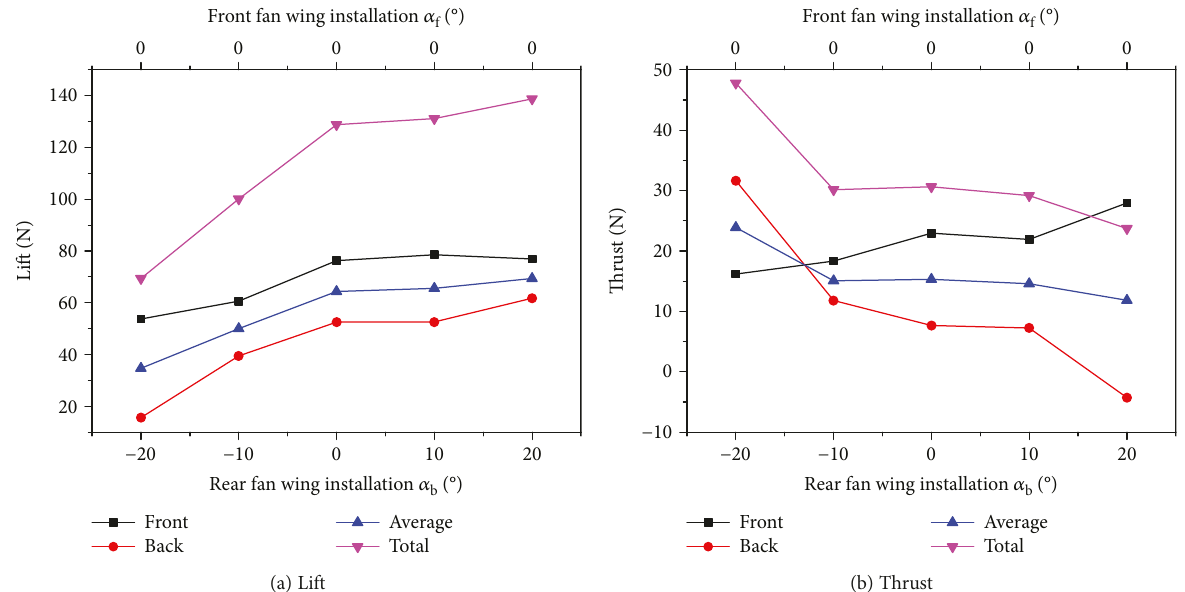
Figure 12: Curve of the lift and thrust of the front and rear fan wings when the front wing is fi